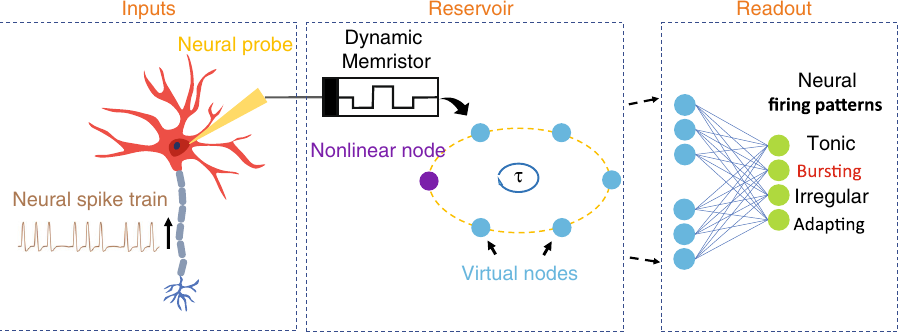
Fig. 1 Schematic showing the concept of a memristor-based RC system for neural activity analysis. Inputs: Neural spikes collected from a fi ring neuron are directly used as inputs to excite the memristor. Reservoir: The reservoir space is further expanded by the concept of virtual nodes to help process complex temporal inputs. Readout: A simple ANN is used as readout layer of the reservoir to produce the fi nal output (e.g. recognizing “ Bursting ” fi ring pattern in this